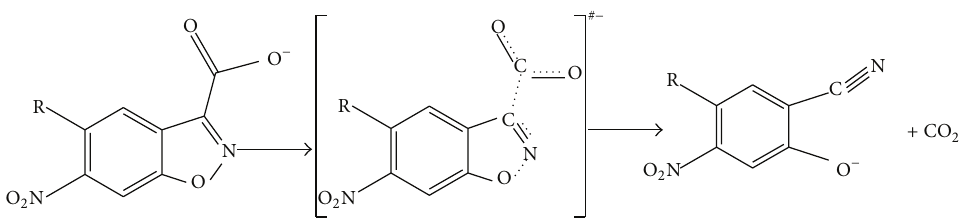
Figure 5: Decarboxylation of substrates 6-NBIC and 6-NBIC-5-Me [41].